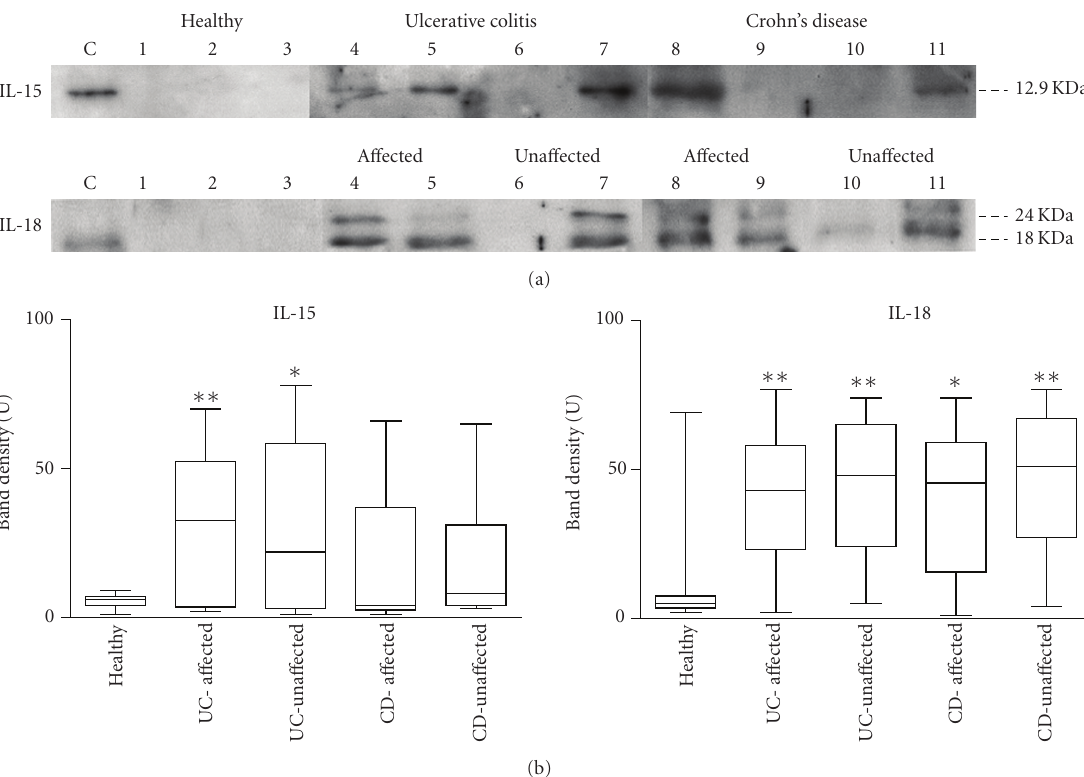
Figure 4: Western-blot analysis of IL-15 and IL-18 in protein extracts from intestinal biopsies. (a) Representative figure of several experiments, analysis of IL-15 (12.9 kDa), IL-18 active form (18kDa), and IL-18 inactive form (24kDa). Control lanes “C”: human recombinant IL-15 or IL-18. Lanes 1–3: healthy controls. Lanes 4-5: a ff ected areas from UC. Lanes 6-7: una ff ected areas from UC. Lanes 8-9: a ff ected areas from CD. Lanes 10-11: una ff ected areas from CD. (b) Densitometric band analysis, statistical di ff erences respect to healthy controls are shown. ∗∗ P < . 05 and ∗ P < . 01 .